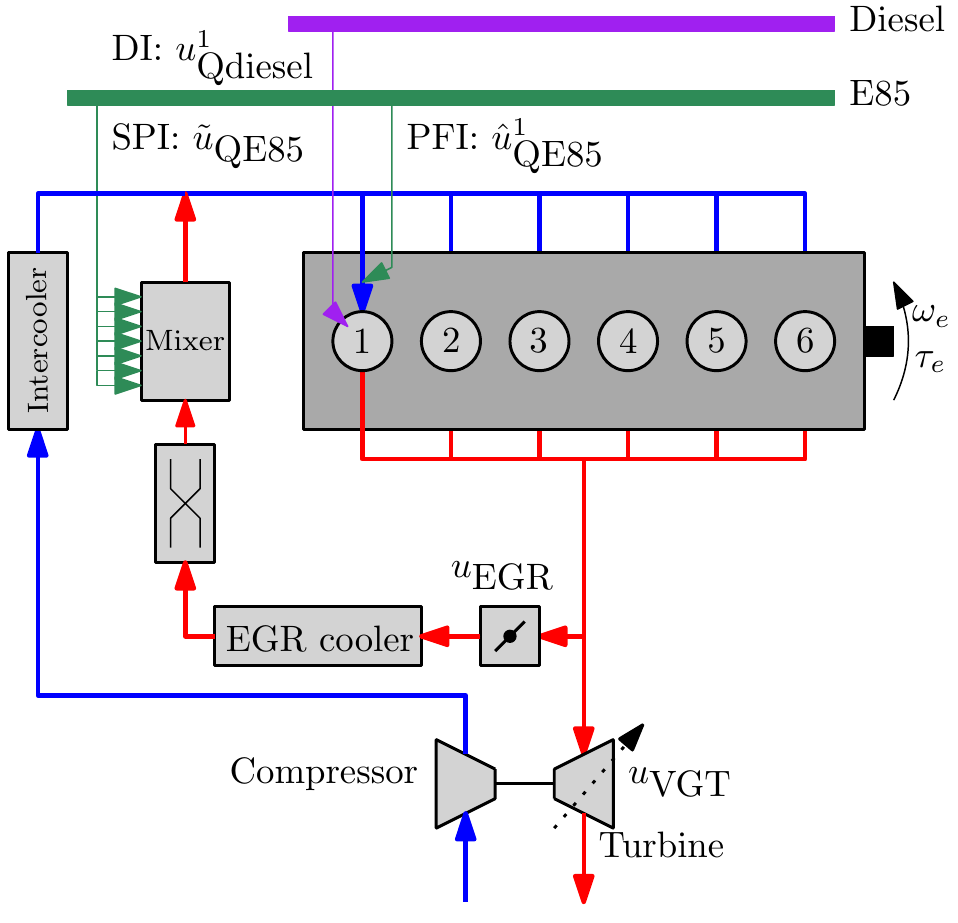
Figure 1. Scheme of the studied dual fuel RCCI engine with both diesel (purple) and E85 (green) fuel paths illustrated for cylinder 1